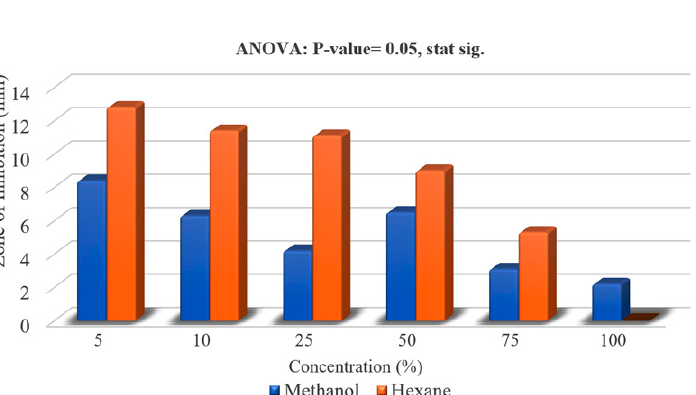
Fig. 6. Difference in zone of inhibition at different conc. for methanol and hexane extract of M. oleifera